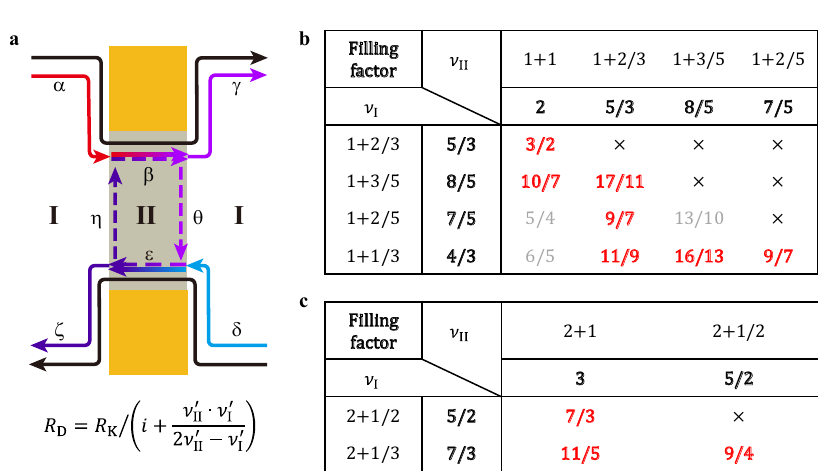
region and region II represents the con fi ned region, as described in Fig. 1a. The equation is Eq. 1 in the text. b Predicted plateaus in 1< ν ≤ 2 according to Eq. 1. Fractionsinredboldfontindicateplateausobservedinexperimentswhilethosein gray font haven ’ t been observed. Crosses indicate cases that do not apply to the model. c Predicted plateaus in 2< ν ≤ 3 when taking i =2 in Eq.